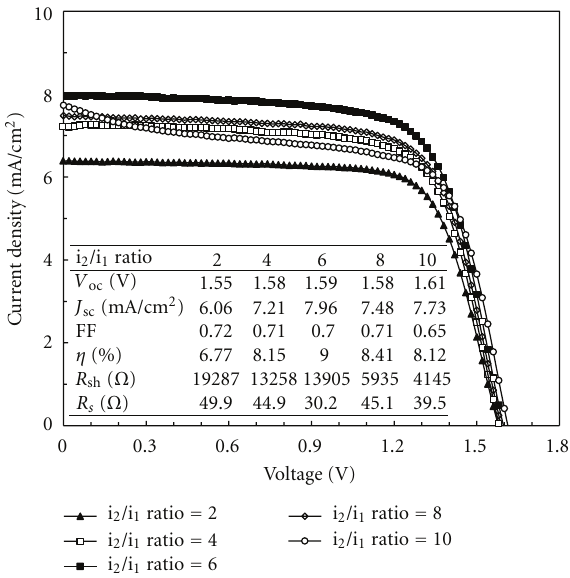
Figure 4: I-V characteristics of a-Si/a-Si tandem solar cells with di ff erent i 2 /i 1